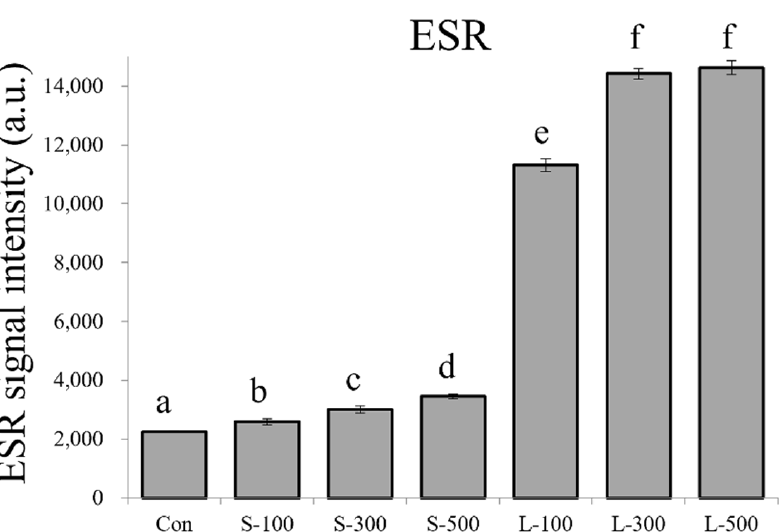
Figure 1. Measurements of the free radical content in wheat seeds following short- and long-term gamma irradiation using electron spin resonance (ESR). Con, non-irradiated seeds (0 Gy); S, short- term irradiation; L, long-term irradiation; 100, 300, and 500, gamma irradiation doses. Each bar represents the mean ± standard deviation (SD). Values with different letters are significantly different using Duncan’s multiple range test ( p < 0.05).